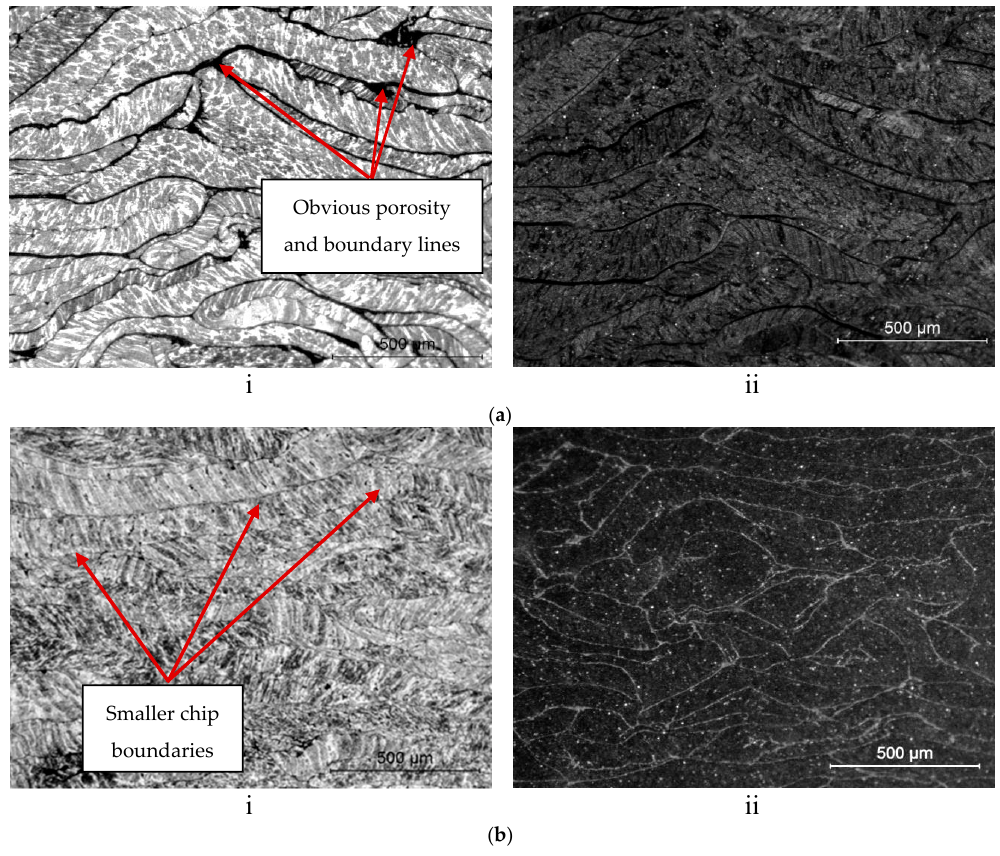
Figure 5. Microstructure of minimum–maximum parameter: ( i ) bright field; and ( ii ) under polarized light. ( a ) S1-T1 (430 °C/60 min); ( b ) S9-T1 (530 °C/120 min).